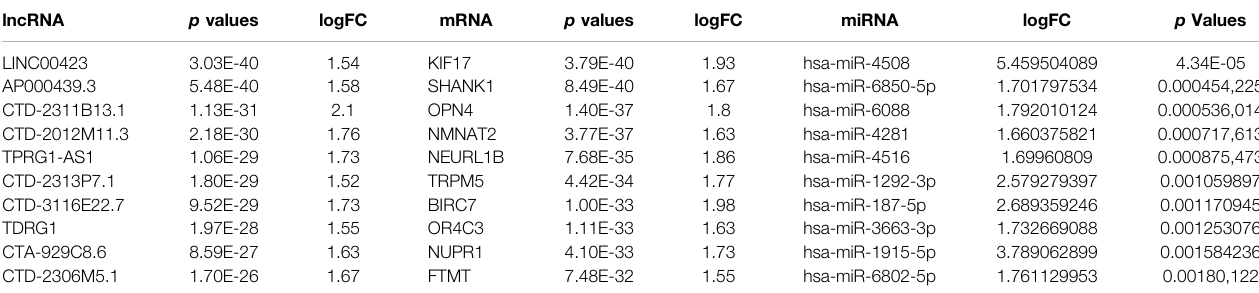
TABLE 1 | Top 10 differentially expressed micro RNAs (miRNAs), messenger RNAs (mRNAs), and long non-coding RNAs (lnc-RNA). lncRNA p values logFC mRNA p values logFC miRNA logFC p